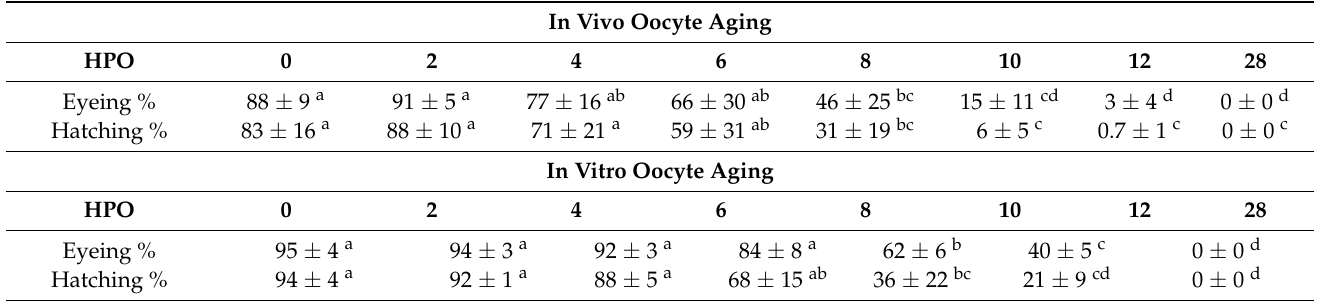
Table 1. Effects of in vivo and in vitro oocyte aging at 20 °C on the eyeing and hatching rates in common carp (mean ± SD). Means sharing a common alphabetical symbol do not differ significantly.